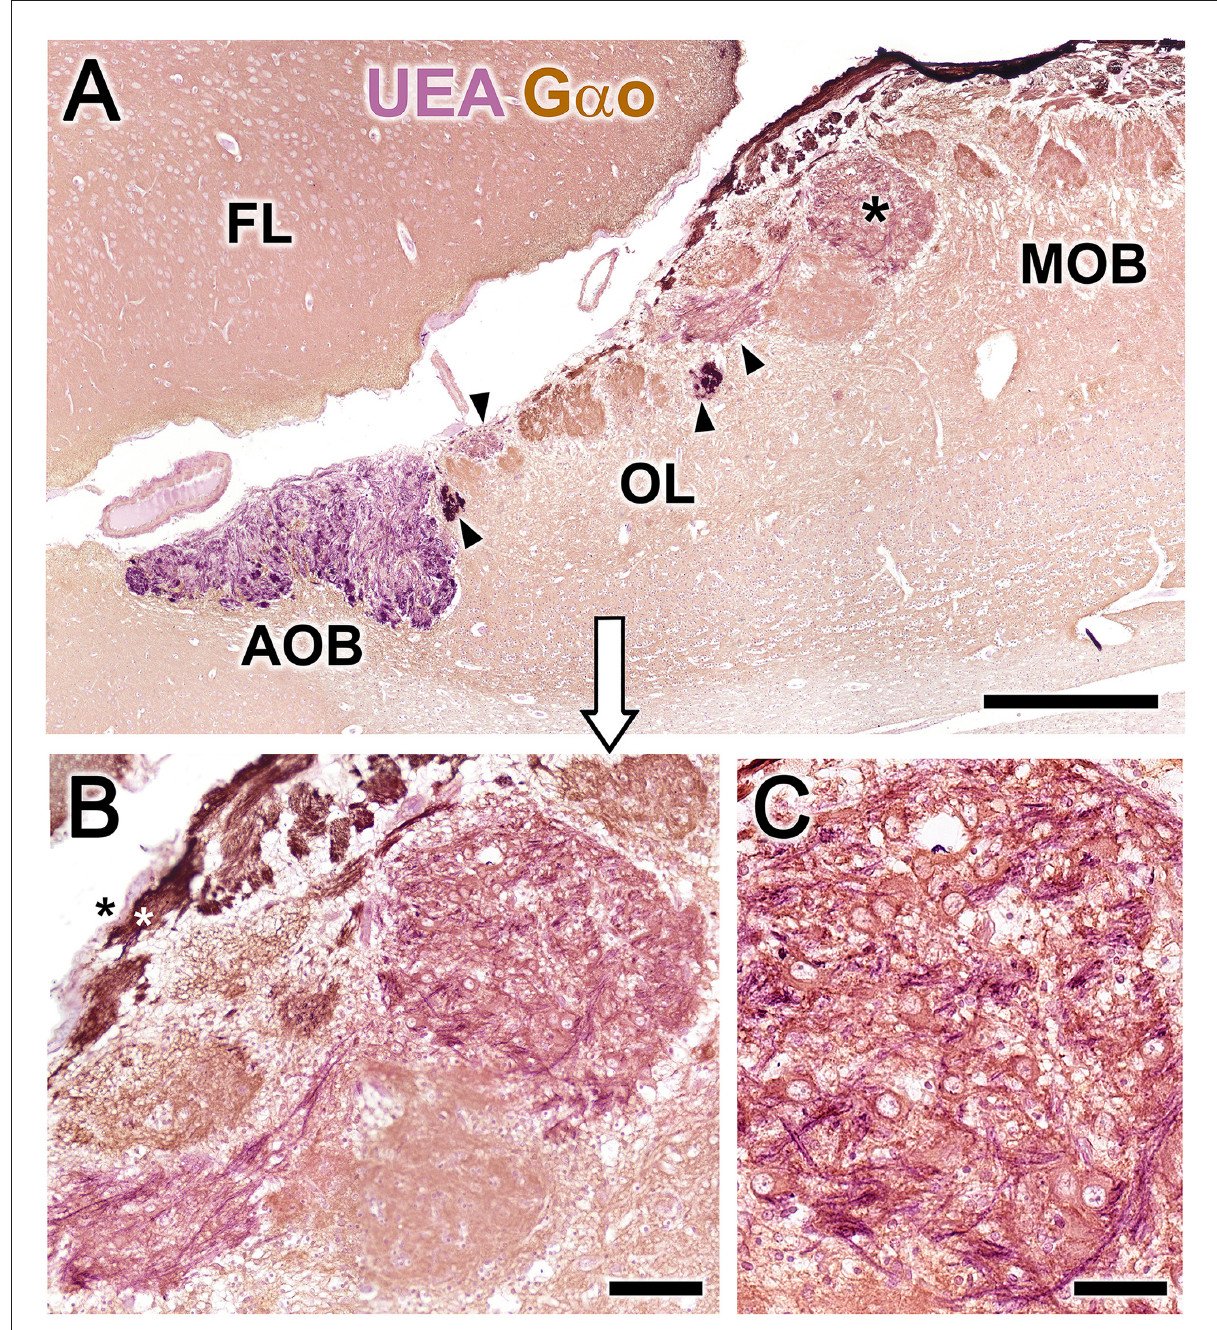
FIGURE8 Double-immunohistochemical labeling of the fox olfactory limbus (OL). Double immunostaining with the lectin Ulex europaeus agglutinin (UEA, magenta) and G α o antibody (brown). (A) The nerve and glomerular layers of the accessory olfactory bulb (AOB) are intensely labeled by UEA, whereas the main olfactory bulb (MOB) is not. In the OL, some glomeruli are UEA-negative, whereas smaller glomeruli are strongly UEA-positive (arrowheads). The macroglomerular complex (MGC, asterisk) is also UEA-positive. (B) Higher magnification of the MGC area, showing G α o- positive somata embedded in a dense network of UEA-positive fibers. The vomeronasal nerve fibers segregate into UEA-positive (black asterisk) and G α o-positive (white asterisk components). (C) The MGC somata are oval in shape and G α o-positive. FL, Frontal lobe of the telencephalon. Scale bars: (A) : 500 µ m. (B) : 50 µ